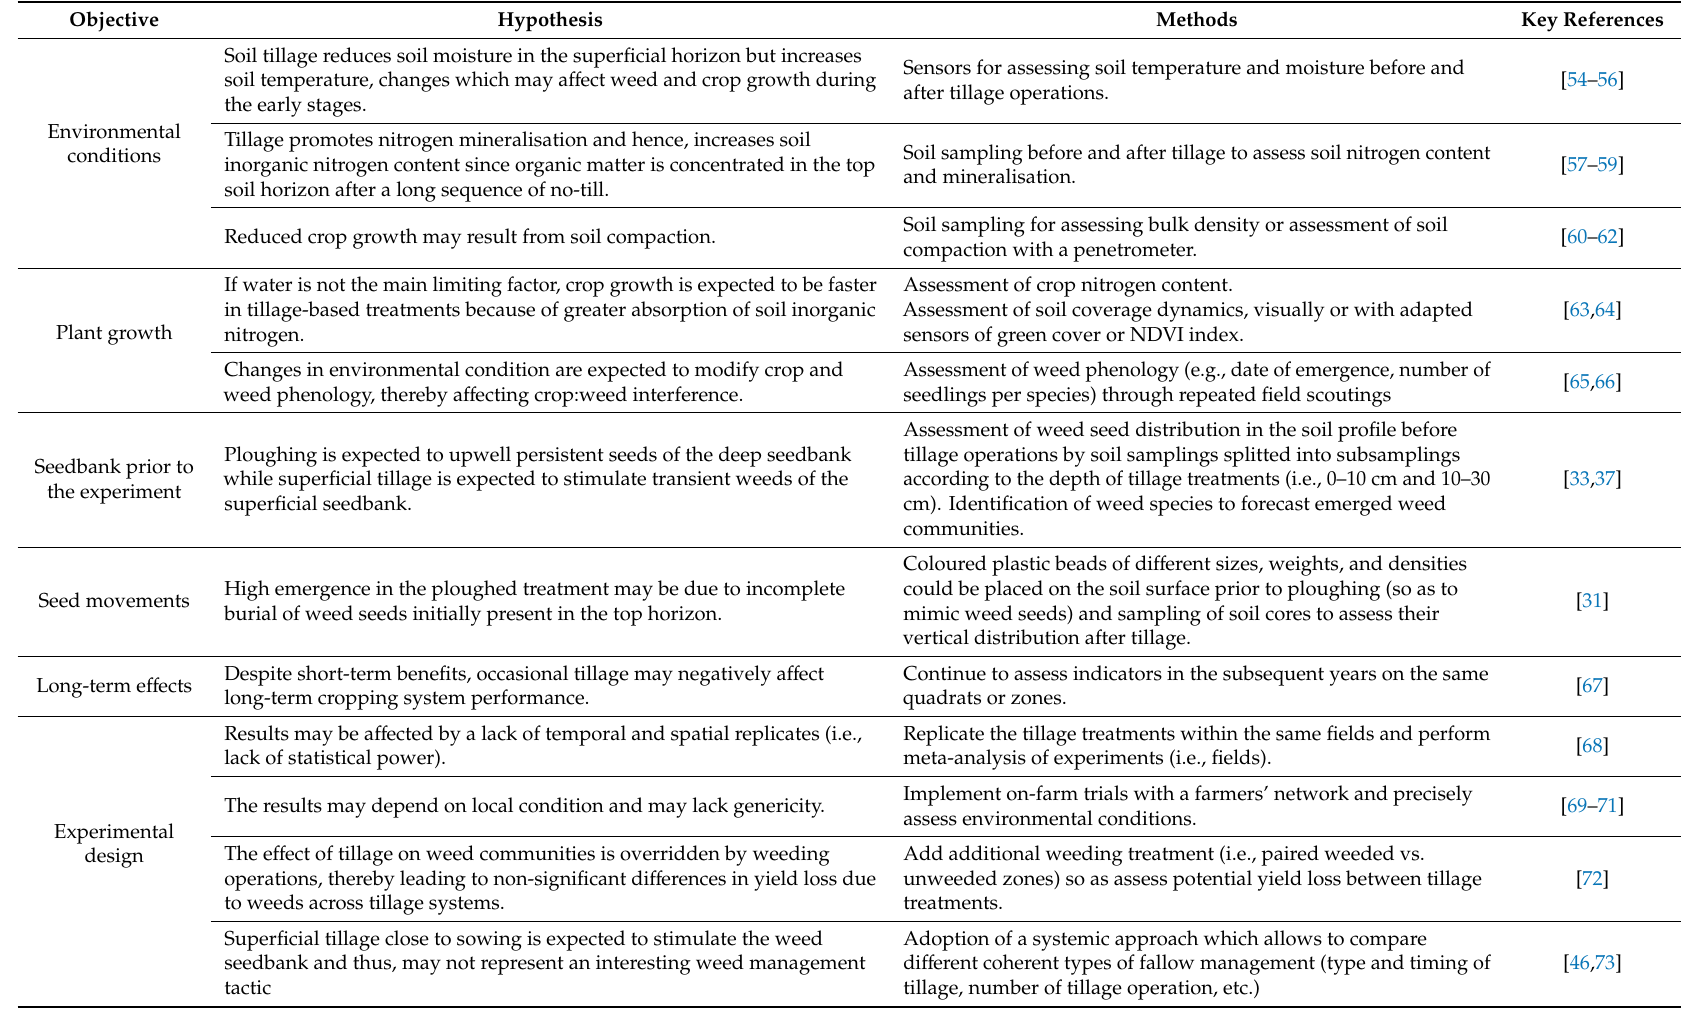
Table 2. Guide for a better understanding of the processes underlying tillage e ff ects on weed communities and crop performance in fields previously conducted under conservation agriculture